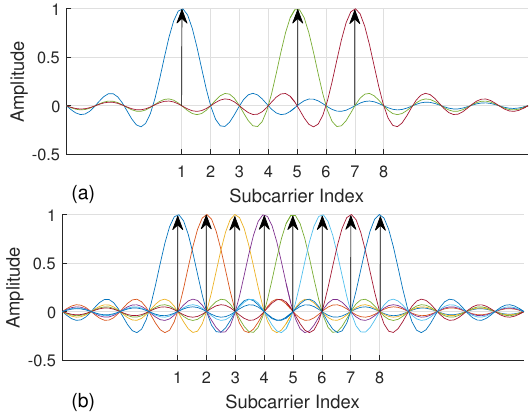
Figure 1. Subcarrier presentation in frequency domain for OFDM and OFDM-IM. Each color refers to a single subcarrier. ( a ) Three out of eight subcarriers are activated in OFDM-IM. ( b ) All of eight subcarriers are utilized in